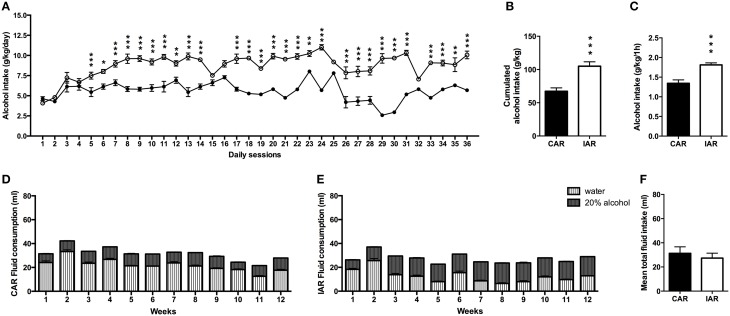
Pre-gestational drinking behavior. (A) Alcohol intake (expressed in g/kg/day) during the 36 pre-gestational drinking sessions in female rats exposed to the home cage, 2-bottle “alcohol vs. water” choice regimen, under the following conditions: CAR, 20% v/v alcohol with continuous access; IAR, 20% v/v alcohol with intermittent access. Results from Bonferroni post-hoc analysis showed a significantly higher alcohol intake in IAR, when compared to CAR, on days 5 (t = 16.125, p < 0.001), 6 (t = 5.188, p < 0.001), 7 (t = 6.427, p < 0.001), 8 (t = 8.561, p < 0.001), 9 (t = 12.09, p < 0.001), 10 (t = 8.868, p < 0.001), 11 (t = 10.11, p < 0.001), 12 (t = 5.746, p < 0.001), 13 (t = 12.14, p < 0.001), 14 (t = 9.174, p < 0.001), 16 (t = 4.671, p < 0.001), 17 (t = 10.37, p < 0.001), 18 (t = 12.05, p < 0.001), 19 (t = 8.776, p < 0.001), 20 (t = 11.24, p < 0.001), 21 (t = 13.16, p < 0.001), 22 (t = 11.21, p < 0.001), 23 (t = 6.084, p < 0.001), 24 (t = 14.62, p < 0.001), 25 (t = 3.794, p < 0.001), 26 (t = 11.51, p < 0.001), 27 (t = 20.13, p < 0.001), 28 (t = 9.102, p < 0.001), 29 (t = 19.12, p < 0.001), 30 (t = 18.44, p < 0.001), 31 (t = 14.12, p < 0.001), 32 (t = 3.410, p < 0.05), 33 (t = 11.88, p < 0.001), 34 (t = 8.977, p < 0.001), 35 (t = 6.714, p < 0.001), and 36 (t = 12.02, p < 0.001). (B) Total sum of alcohol consumed over the entire period. (C) Mean alcohol consumption following the first hour of access. (D) Total fluid intake (ml) in CAR over the 12 pre-gestational weeks. (E) Total fluid intake (ml) in IAR over the 12 pre-gestational weeks. (F) Mean fluid consumption over the entire period. Each point or bar is the mean ± SD of n = 24 rats. *p < 0.05, **p < 0.01, ***p < 0.001 vs. CAR.